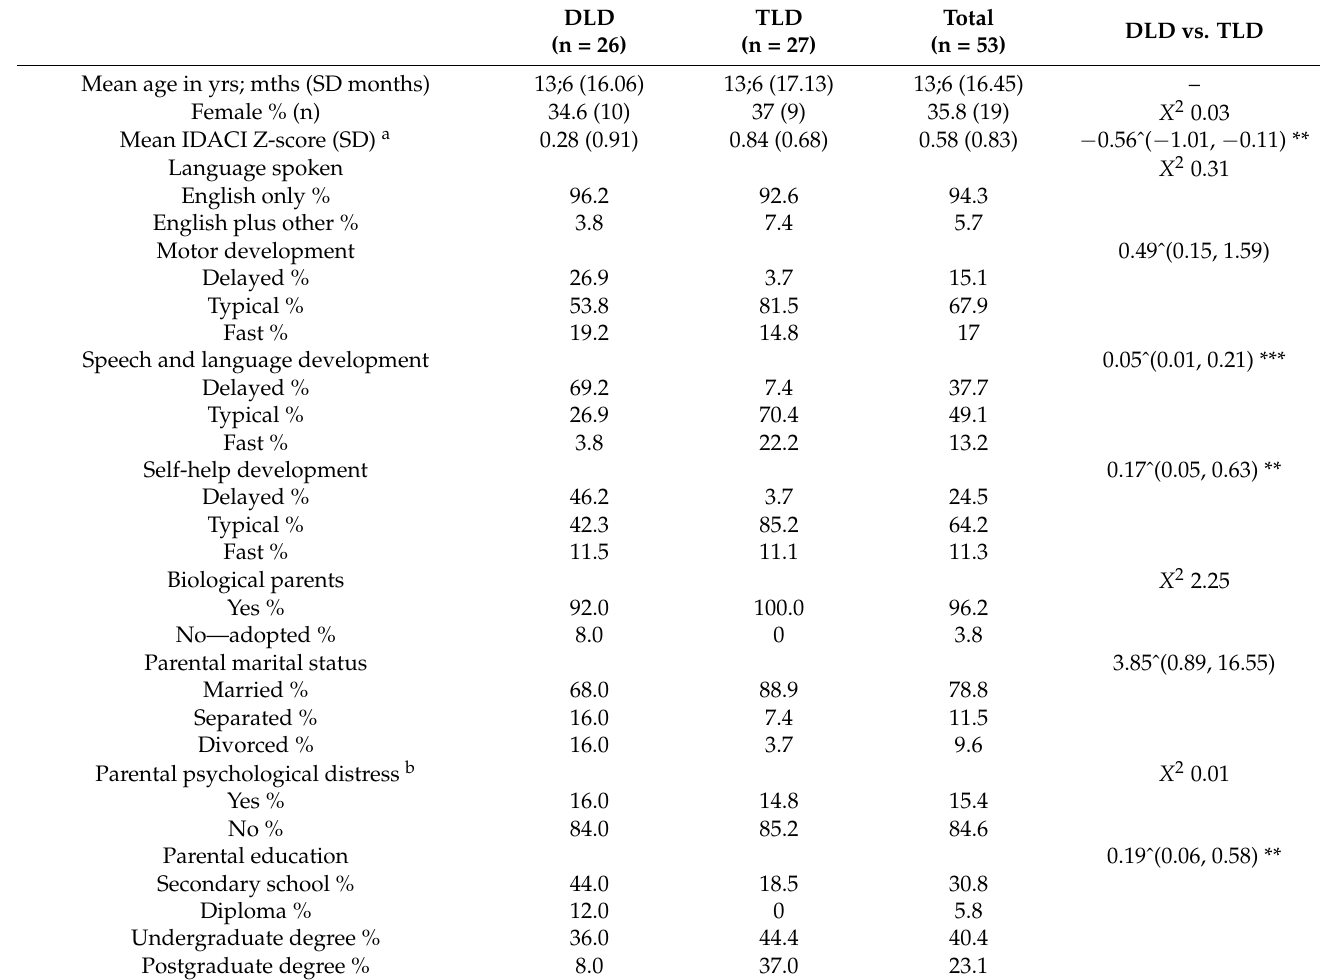
Table 1. Demographics of